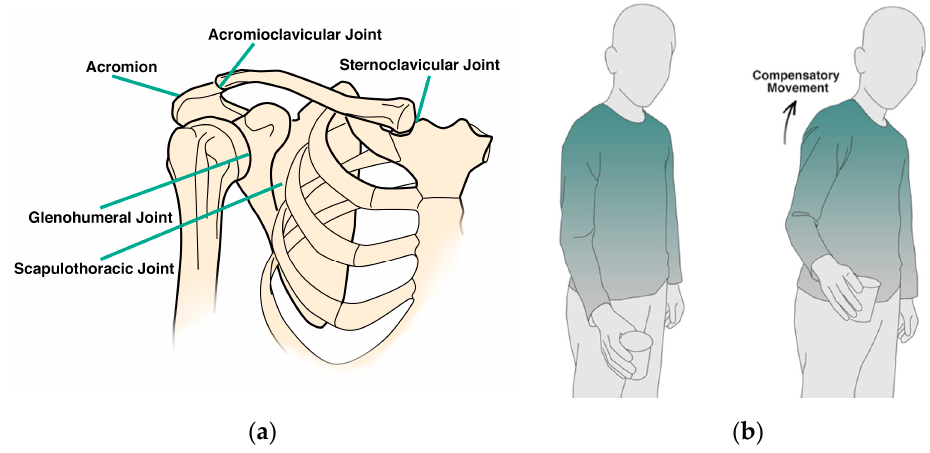
Figure 1. ( a ) Schematic anatomy of shoulder complex; ( b ) The compensatory movement in the task execution.